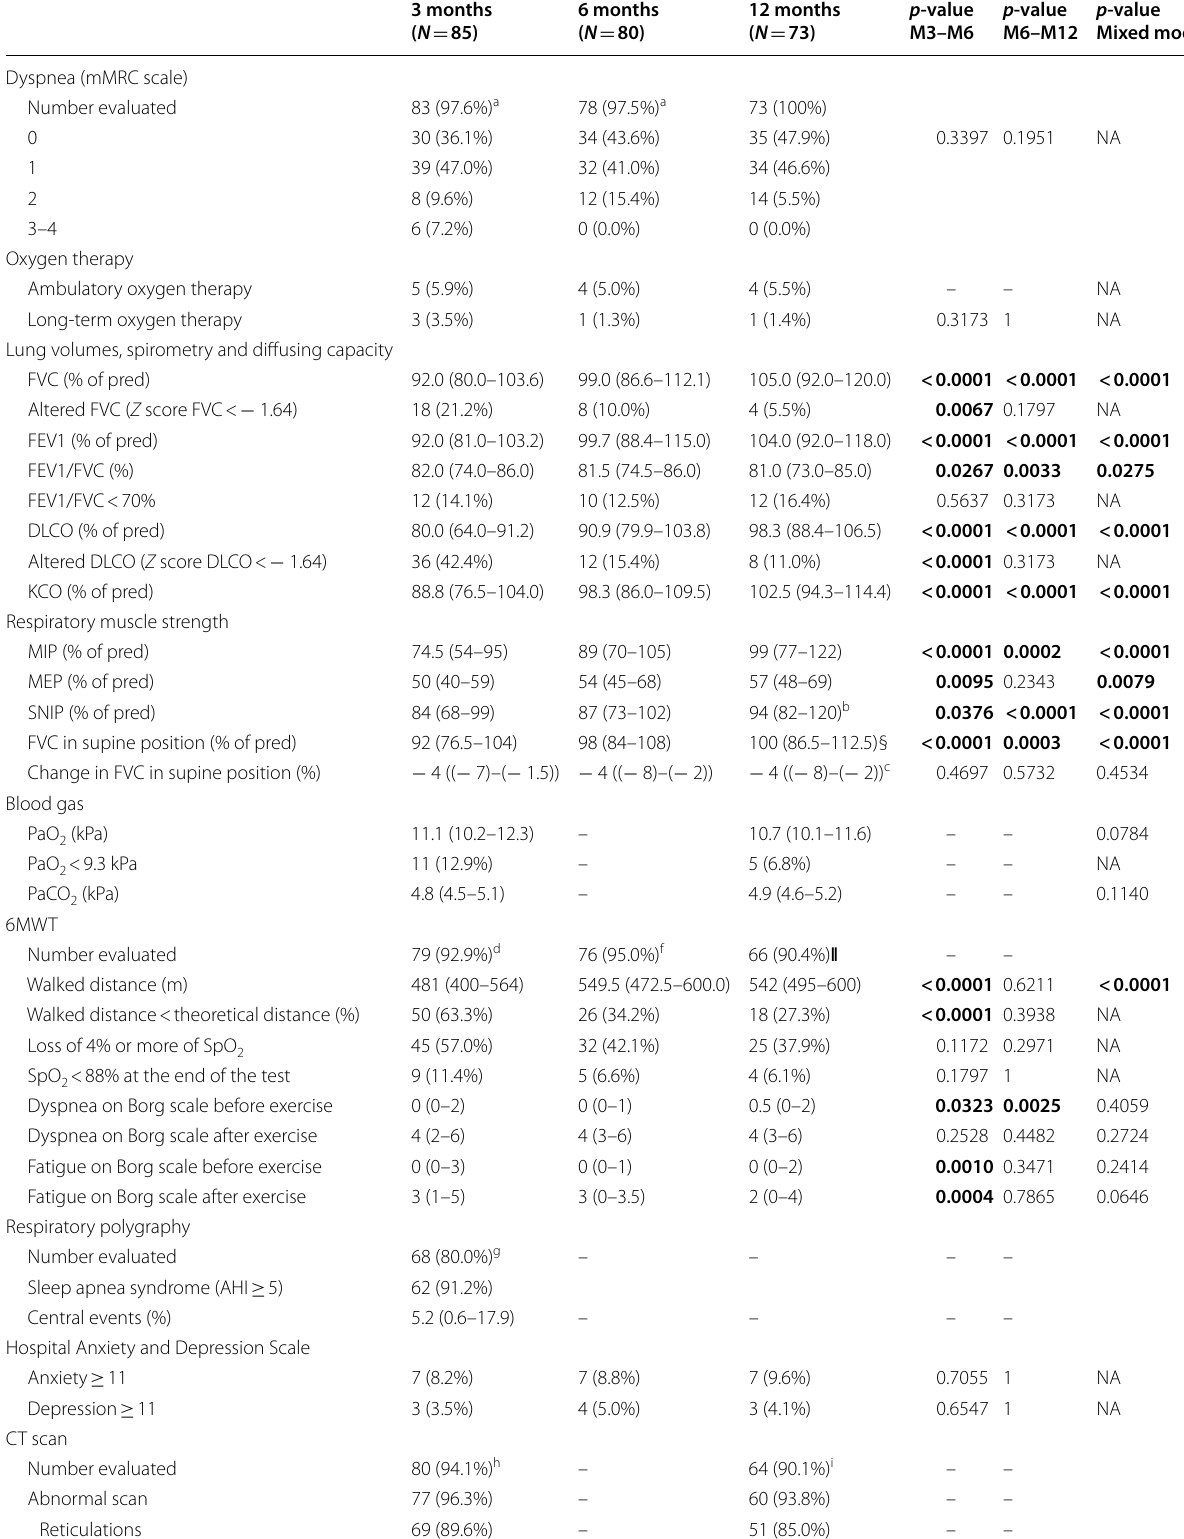
Table 2 Functional, physiological and CT scan data at 3, 6 and 12